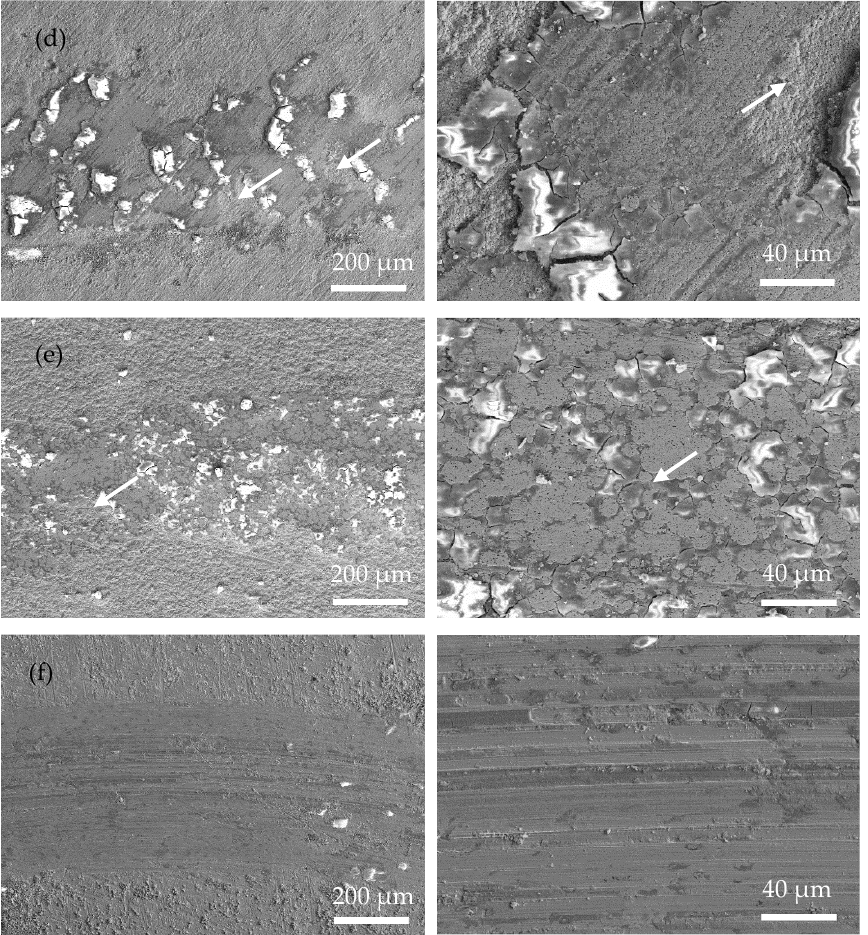
Figure 7. Surface morphology of the wear scar of the as-plated coatings at low magnification (left) and high magnification (right) (white arrow means original surface): ( a ) Ni-P; ( b ) Ni-P-Si 3 N 4 ; ( c ) Ni- P-Si 3 N 4 -WS 2 , 0.5 g/L; ( d ) Ni-P-Si 3 N 4 -WS 2 , 1.5 g/L; ( e ) Ni-P-Si 3 N 4 -WS 2 , 2.5 g/L; and ( f ) Ni-P-WS 2.